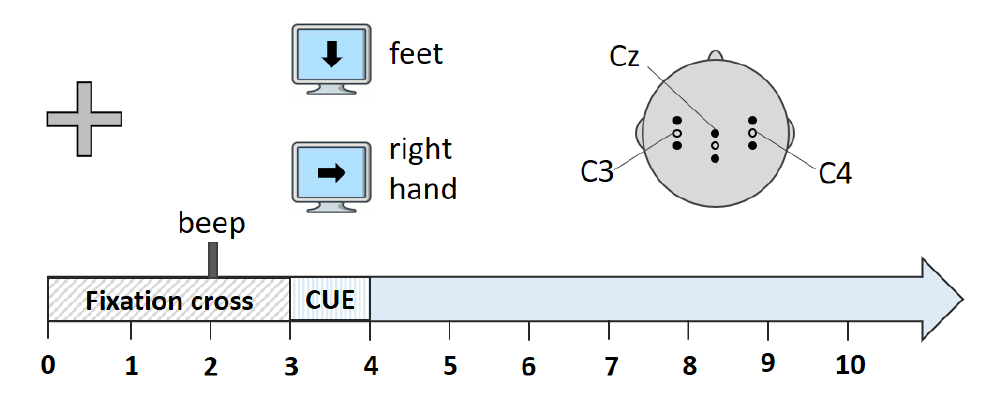
Figure 2. Experiment